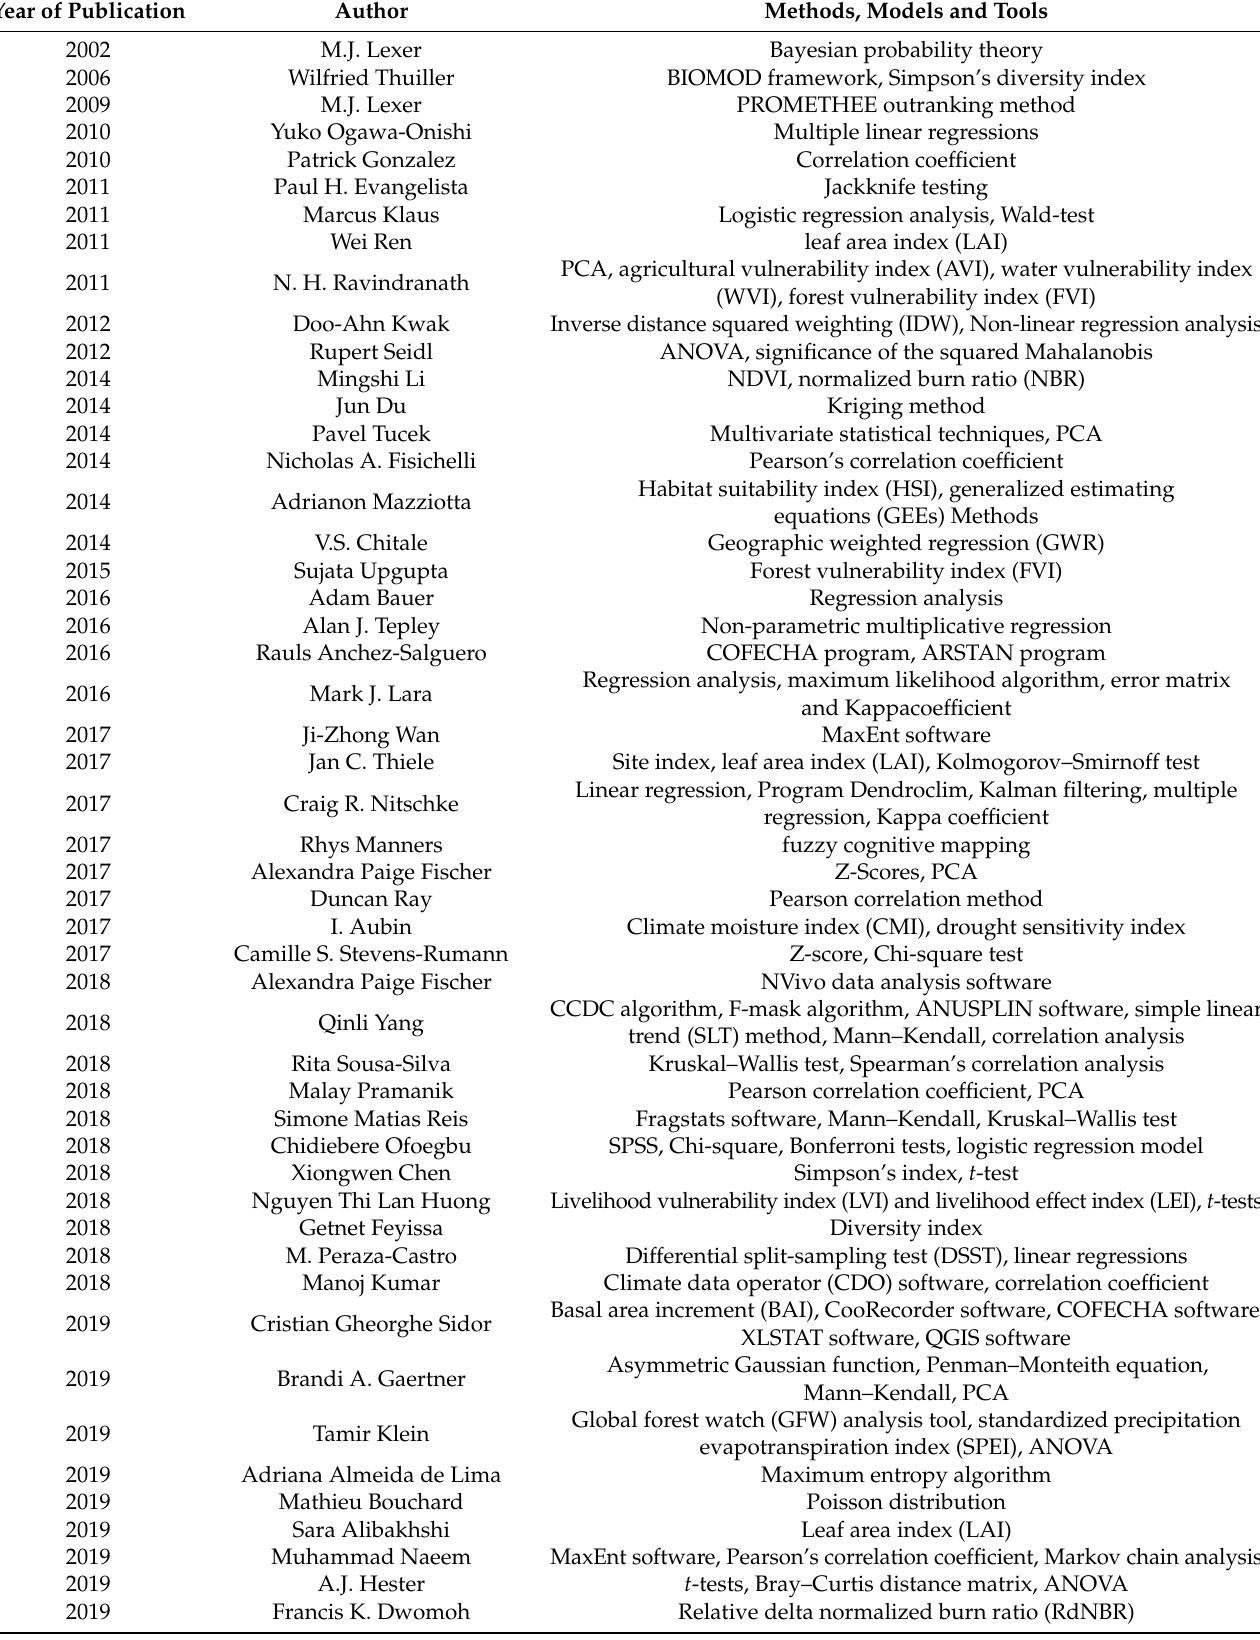
Table 1. Methods, models and tools employed for assessing forest vulnerability to climate